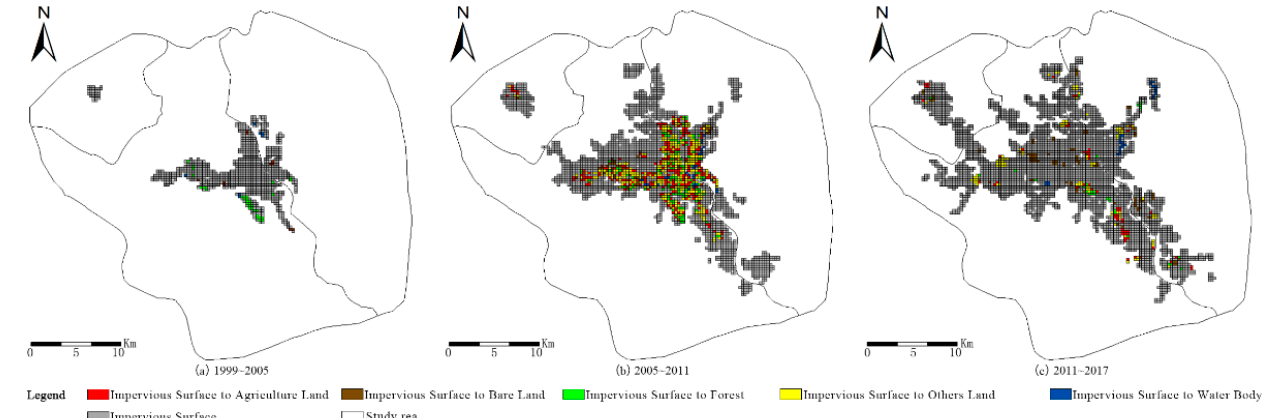
Figure 4. Conversation-out from urban impervious surface in 1999–2017.